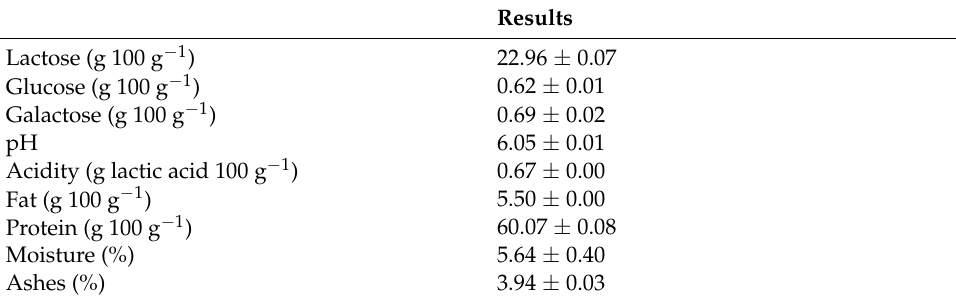
Table 3. Initial composition of the whey protein concentrate.